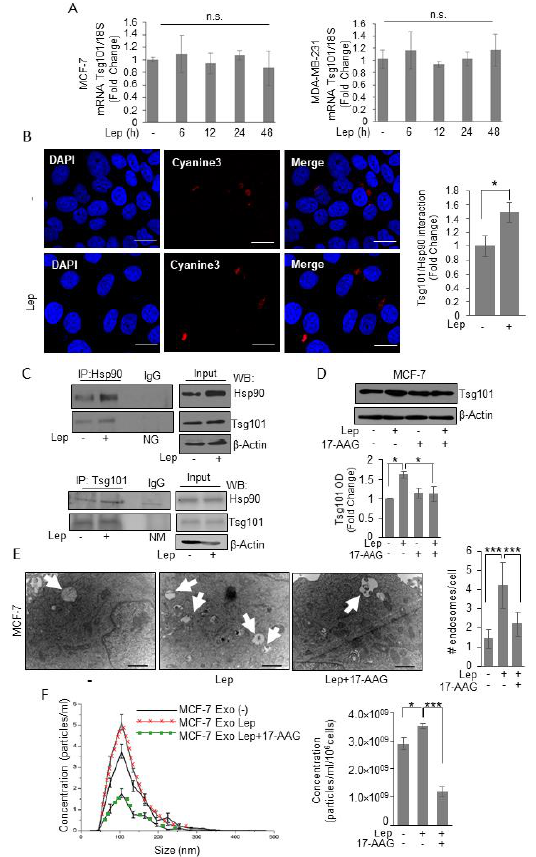
Figure 5. Leptin induces Tsg101–Hsp90 interaction in breast cancer cells. ( A ) Total RNA was extracted from MCF-7 and MDA-MB-231 breast cancer cells treated with vehicle (-) or Leptin (Lep, 500 ng/mL) for 6, 12, 24, and 48 h, then reverse transcribed; cDNAs were subjected to real-time RT-PCR using primers specific for TSG101 . Each sample was normalized to its 18S rRNA content. The values represent the means ± S.D. of three different experiments each performed in triplicate. ( B ) Duolink staining (red) was used to detect Tsg101/Hsp90 interaction in MCF-7 breast cancer cells treated with vehicle (-) or Lep for 48 h. DAPI was used for nuclear staining. Red fluorescence was detected by Cyanine3 filter. Images are representative of three different experiments. Scale bar 10 μm. The histograms represent the relative abundance of the Tsg101/Hsp90 complexes (red dots/DAPI) compared to vehicle-treated samples (-) counted by ImageJ software. ( C ) MCF-7 breast cancer cells were treated with vehicle (-) or Lep for 48 h before lysis. Hsp90 and Tsg101 proteins were immunoprecipitated using anti-Hsp90 (IP:Hsp90) and anti-Tsg101 (IP:Tsg101) antibodies respectively and resolved in SDS–polyacrylamide gel electrophoresis. Immunoblotting was performed using anti-Tsg101 and anti-Hsp90 antibodies respectively. Whole-cell lysates were used as input controls. Negative control was performed by incubation of cell lysates with protein A/G agarose and normal goat (NG) or mouse (NM) antisera. ( D ) Immunoblot analysis of Tsg101 in whole cell lysate of MCF-7 breast cancer cells treated with vehicle (-) or leptin alone or in combination with the Hsp90 inhibitor, 17-AAG (20nM) for 48 h. The histograms represent the average fold change ± S.D. of three separate experiments in which band intensities were evaluated in terms of optical density arbitrary units (OD), and expressed as fold change versus vehicle-treated samples. ( E ) Representative images of transmission electron microscopy (TEM) showing Multivescicular bodies (MVBs) in MCF-7 cells treated with vehicle (-) or Leptin (Lep, 500 ng/mL) and/or 17-AAG (20 nM) for 48 h. Scale bar 1 μm. The histograms represent the mean ± S.D. of the MVB numbers in more than 15 fields per condition. ( F ) Representative size distribution profiles of exosomes (Exo), measured by nanoparticle tracking analysis, from conditioned media of MCF-7 breast cancer cells treated with vehicle (-) or Leptin (Lep, 500 ng/mL) alone or in combination with 17-AAG (20 nM) for 48 h. The histograms represent the mean ± S.D. of exosome concentration (particles/mL/10 6 cells) of two different experiments. * p < 0.05, *** p < 0.001. n.s. nonsignificant.